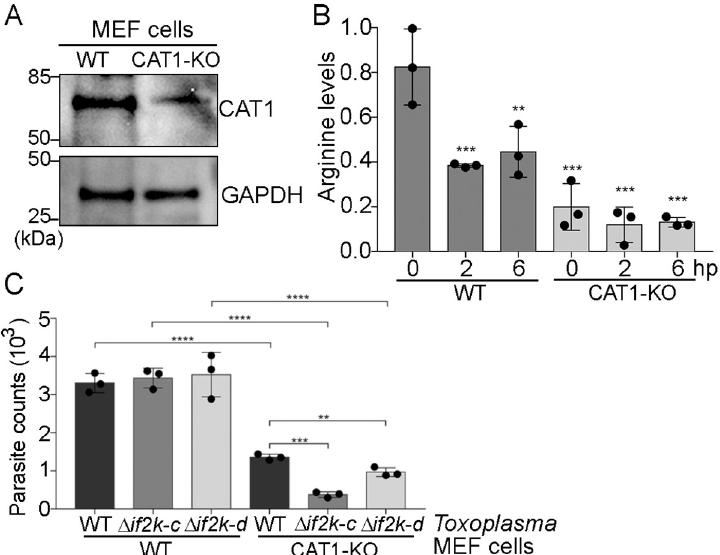
Fig 5. CAT1 facilitates replication of Toxoplasma . (A) CAT1 was depleted from MEF cells using CRISPR-Cas9 and levels of CAT1 protein were measured by immunoblot. (B) Levels of host arginine were measured in wild-type (WT) MEF cells or those depleted for CAT1 (CAT1-KO) and infected with Toxoplasma for 2 or 6 h. Values of infected cells were normalized to mock-infected cells, indicated as 0 hpi ( ± SD, n = 3) �� p < 0.001, ��� p < 0.0005. (C) At 30 hpi, genomic DNA was isolated and numbers of parasites inside WT or CAT1-KO MEF cells were determined by a qPCR assay. WT Toxoplasma parasites or those deleted for TgIF2K-C or TgIF2K-D were used to infect the indicated MEF cells for 30 hpi. Error bars represent standard deviation (n = 3). �� p < 0.001, ��� p < 0.0005, ���� p <